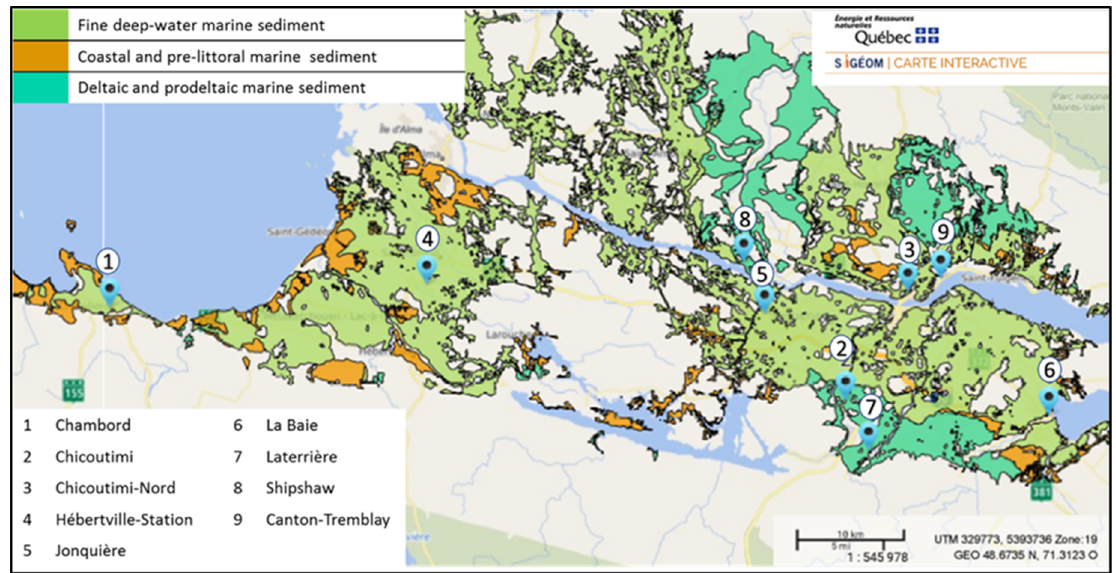
Figure 3. Sampling sites and surficial quaternary geology (modified from [13]).